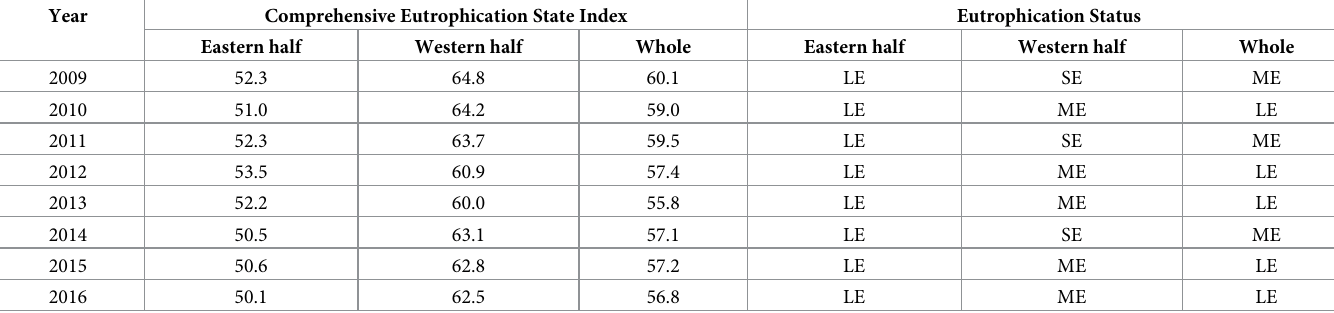
Table 2. Eutrophication status of Chaohu Lake from 2009 to